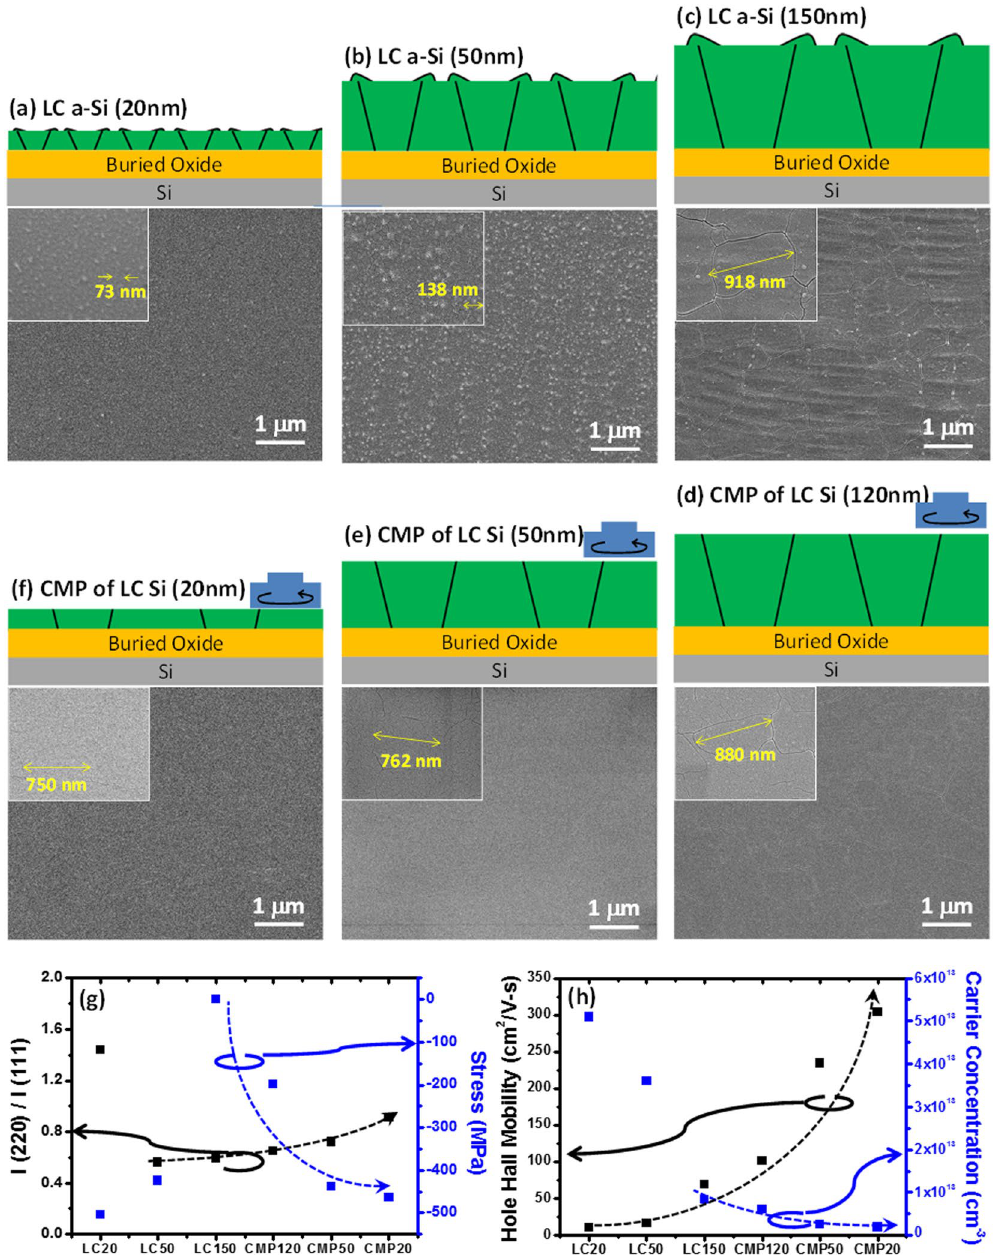
Figure 2. ( a – c ) Top view morphologies and cross-sectional schematics of laser crystallized poly-Si thin films at different original a-Si thickness. Insets show the typical grain size with high magnification. ( d – f ) Top view morphologies and cross-sectional schematics of poly-Si thin films after the CMP planarization from the original a-Si thickness of 150 nm. Insets show the typical grain size with high magnification. ( g ) Intensity ratio of (220)/ (111) planes and stress for different crystallized poly-Si thin films. ( h ) Bulk mobility of carrier concentrations for different crystallized poly-Si thin